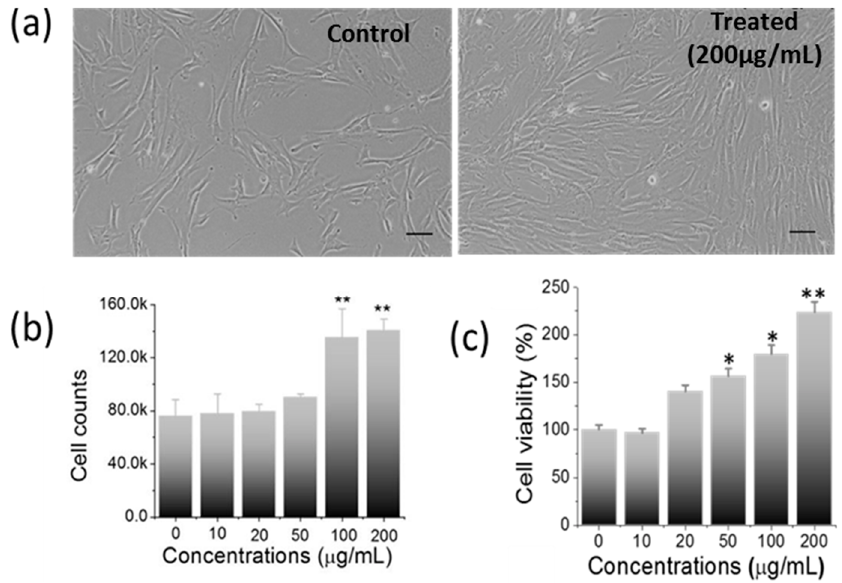
Figure 3. Impact of nanosheet treatment on cellular behavior. ( a ) Phase-contrast micrographs showing normal fibroblast-like morphology in treated hWJ-MSCs with an enhanced proliferation at 200 µg/mL than control (Scale bar: 50 µm), ( b ) Graph showing ≈ 2-fold enhanced cell count in treated cells vs. control cells, ( c ) Significant increase in cell viability analyzed by MTT assay. (* p -value < 0.05; ** p -value < 0.001).